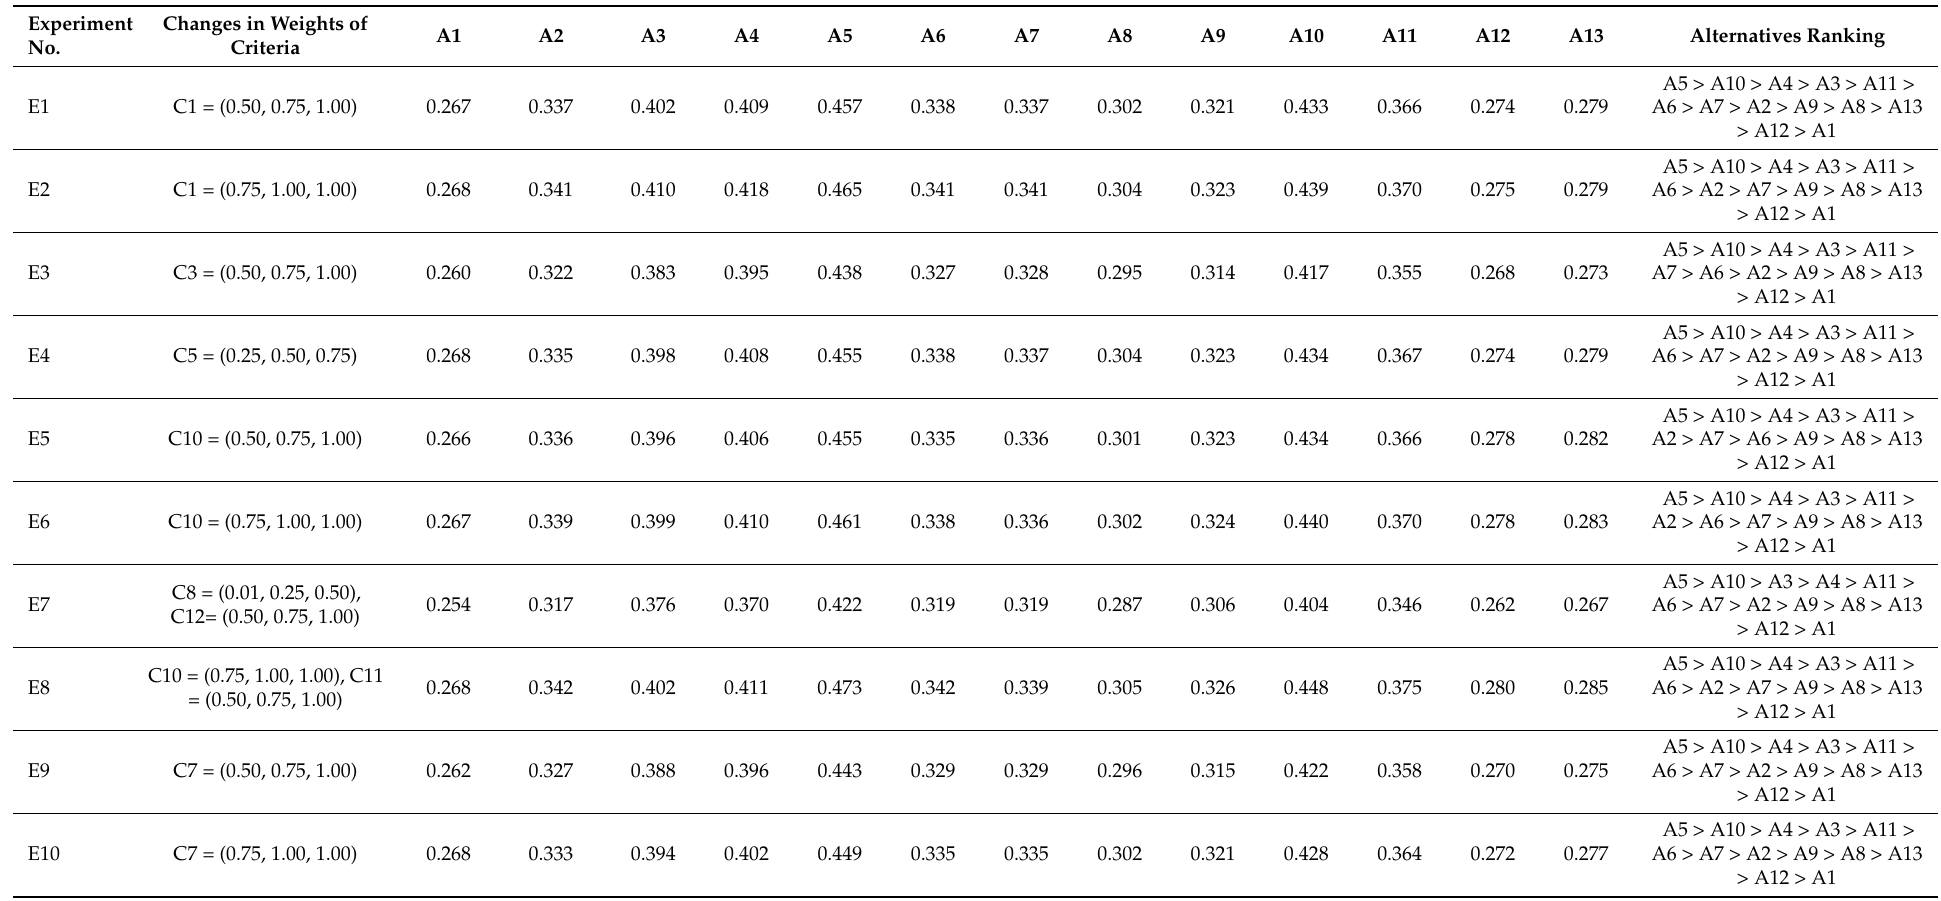
Table 9. Quantitative results of the sensitivity